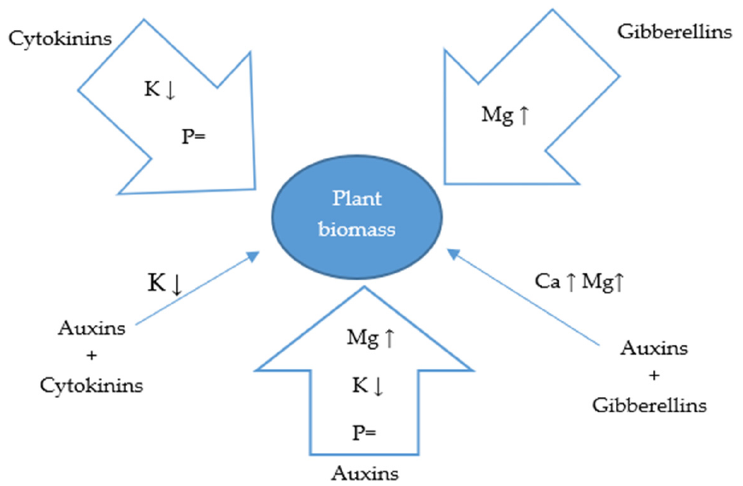
Figure 3. The influence of phytohormones on the chemical composition of biomass: increase ↑ , decrease ↓ , no change =.